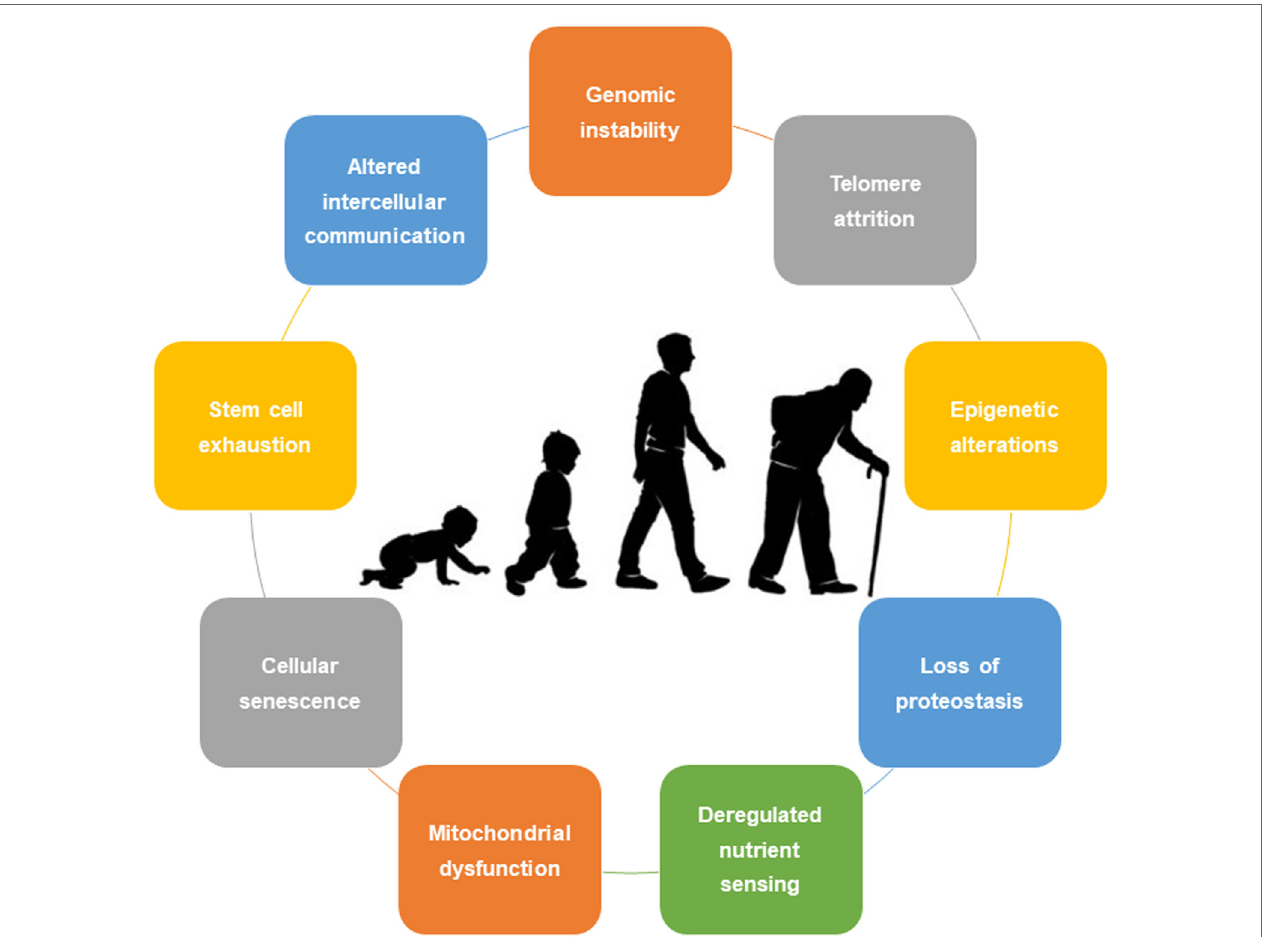
FigURe 1 | Nine cellular hallmarks contributing to